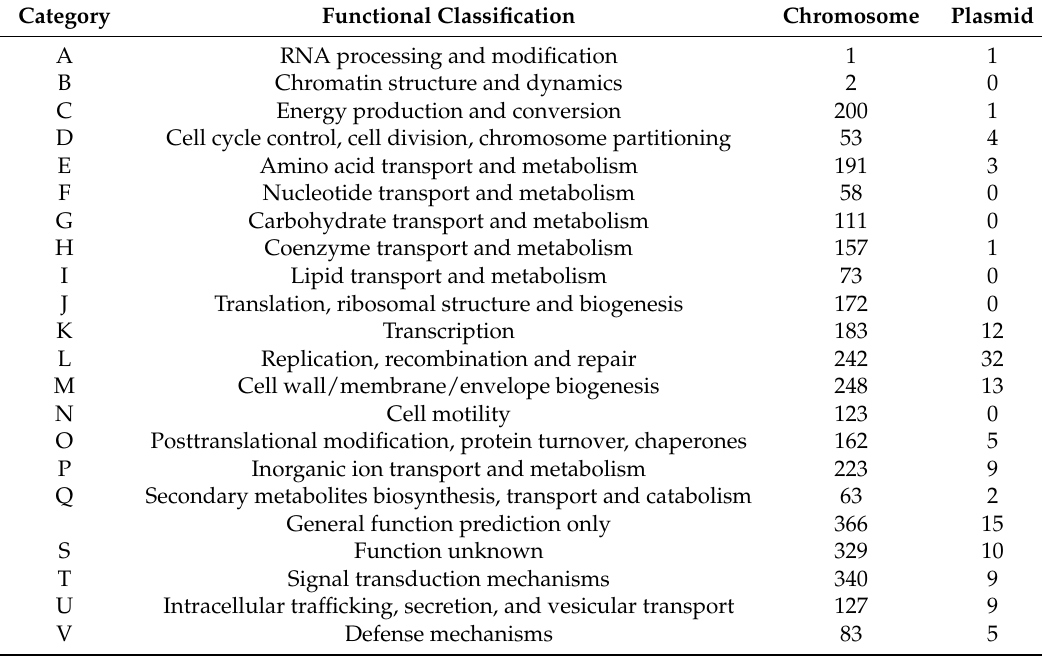
Table 2. The COG function classification of the Methylomonas sp. DH-1